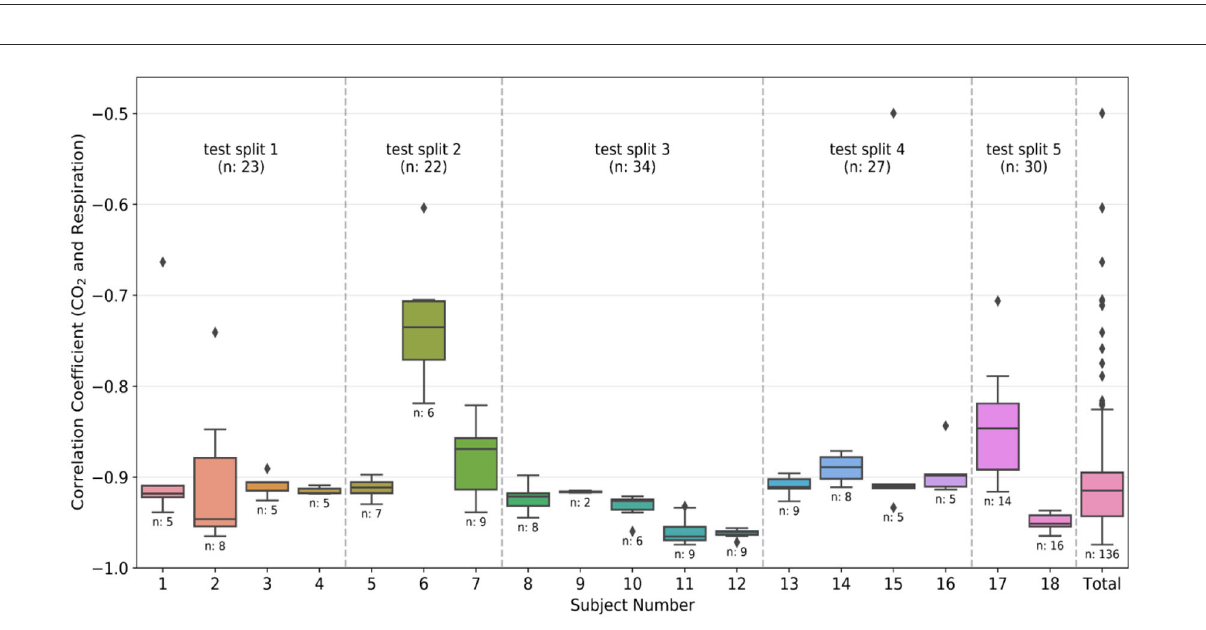
architecture. This modeling is analogous to prevalent image-to- image translation or semantic segmentation using 2D FCNs (Long et al., 2015; Alotaibi, 2020). However, most recent works in